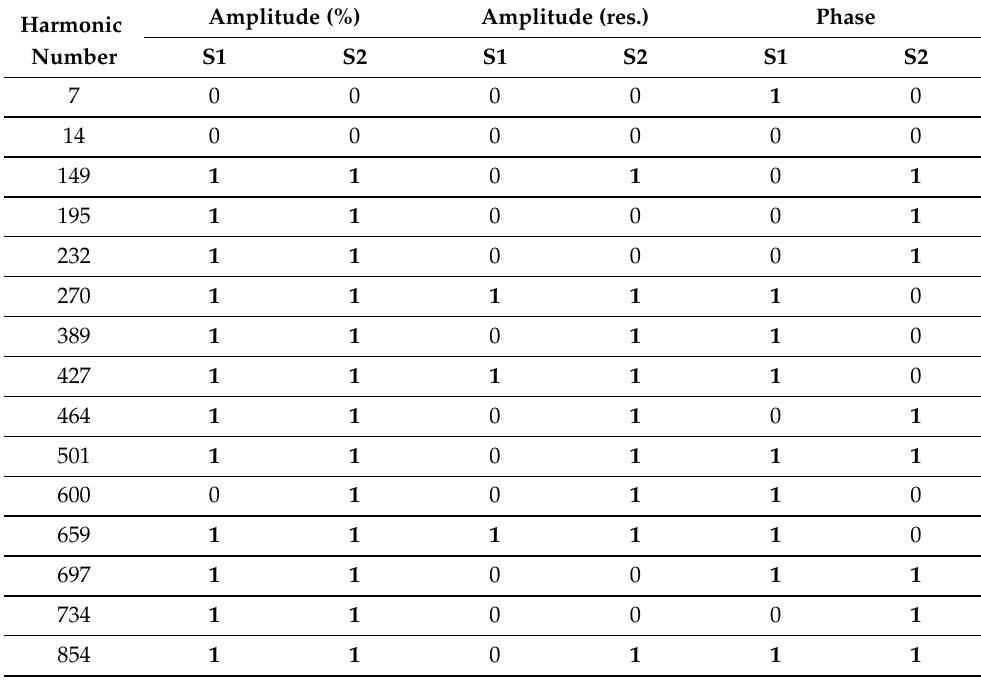
Table 4. AD results for wind-fault event as seen by S 1 and S 2